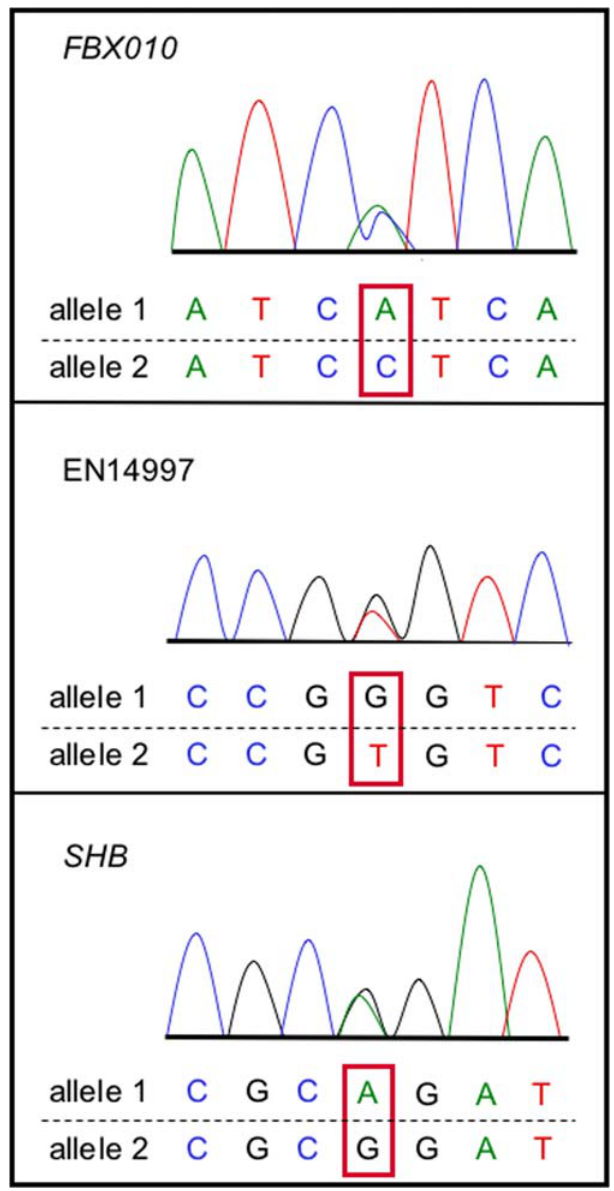
Figure 1. Biallelic expression of three X-specific genes. SNPs (marked by boxes) were identified in the genome sequence demon- strated by sequencing fibroblast cDNA from the sequenced animal (‘‘Glennie’’).